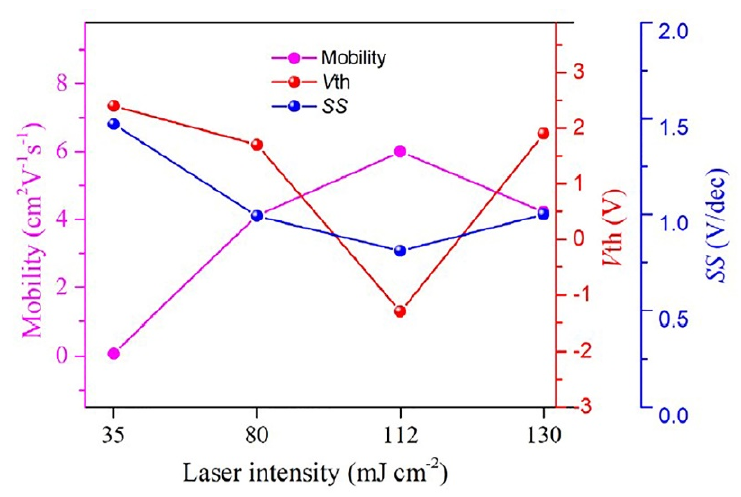
Figure 7. Variation in device performance results of IGZO-TFTs as a function of laser intensity [75].